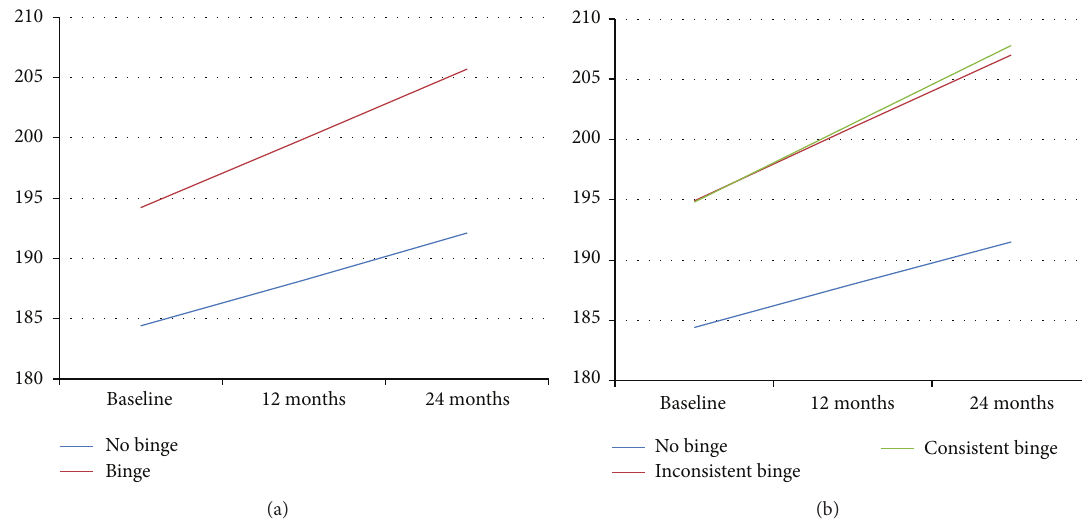
Figure 2: Weight (lbs) by (a) baseline binge eating status and (b) binge eating